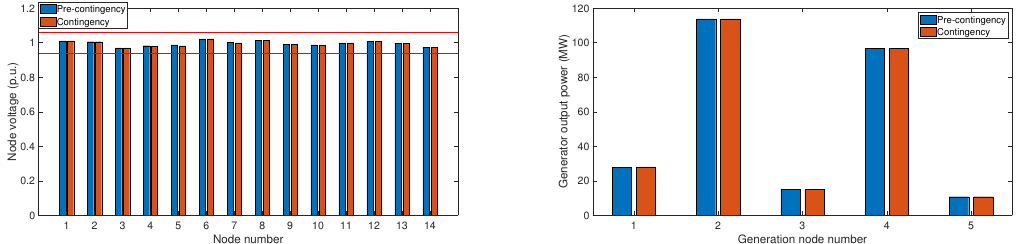
Figure 8. Voltage and power dispatched implementing the QCQP results in a power flow of the network prior to and after contingency of branch 5 (generation nodes are, respectively, nodes 1, 2, 3, 6, and 8).